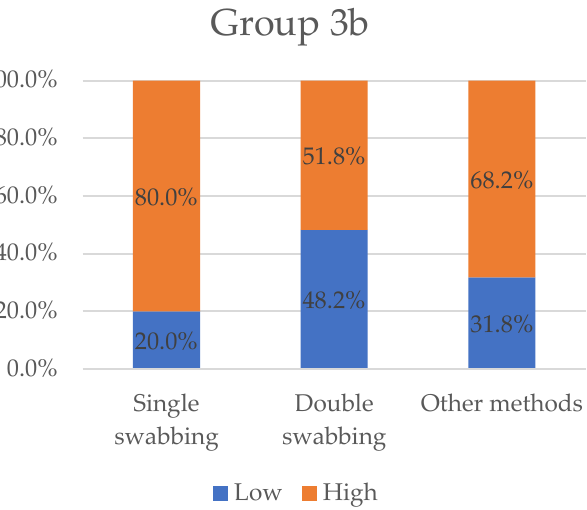
Figure 6. Variables “low” and “high” grouped by sampling methods for Group 3b. Single-swabbing appears to be the most efficient technique, with a “high” value equal to 80%. Other methods and double-swabbing collected 68.2% and 51.8%, respectively.